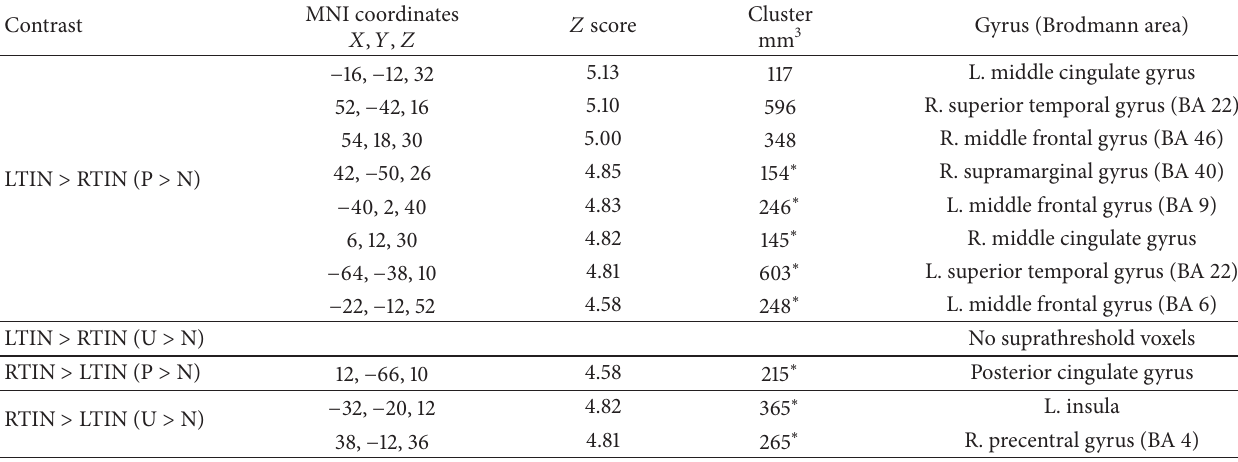
Table 5: Local maxima for the whole-brain independent sample t -tests in the emotion task experiment. Whole-brain independent sample t -tests were computed for between-group differences. Regions are listed in Montreal Neurological Institute (MNI) coordinates. Brodmann areas are also provided (before determining the Brodmann areas, the MNI coordinates were converted to Talairach coordinates). Statistical threshold was set at 𝑝 < 0.025 FWE corrected for multiple comparisons ( ∗ indicates significance at cluster level only). L: left; R: